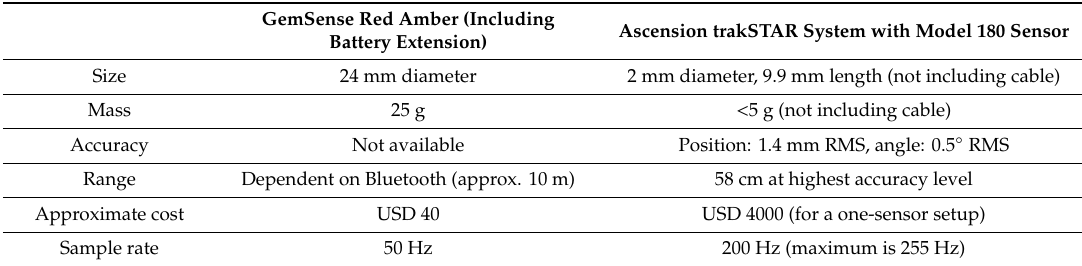
Table 1. Comparison of motion capture devices used in the